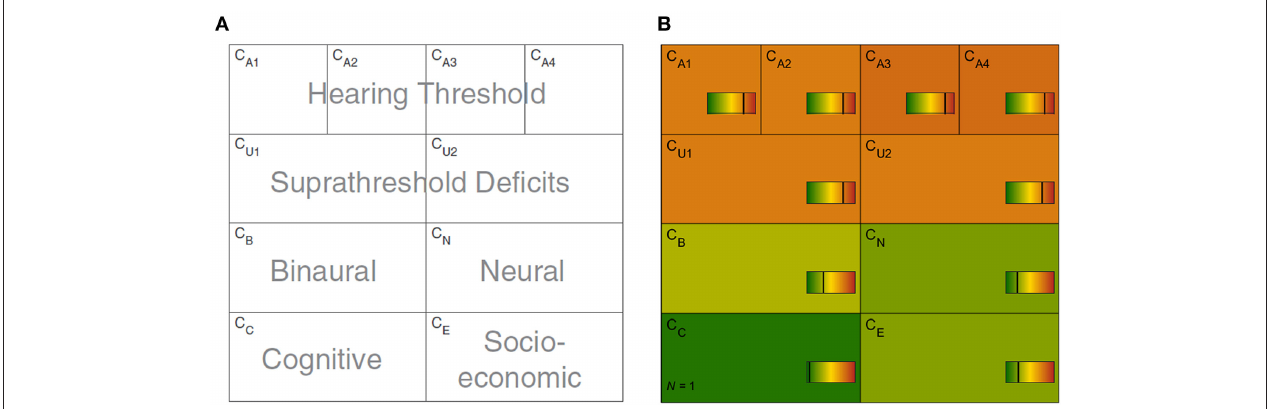
FIGURE 1 | Common Audiological Functional Parameters (CAFPAs). (A) Functional aspects of the human auditory system represented by the CAFPAs. (B) Exemplary CAFPA representation. The color bar corresponds to the interval [0 1]. The respective value of each CAFPA is indicated by the color of the area, as well as by the vertical line within the color bar.